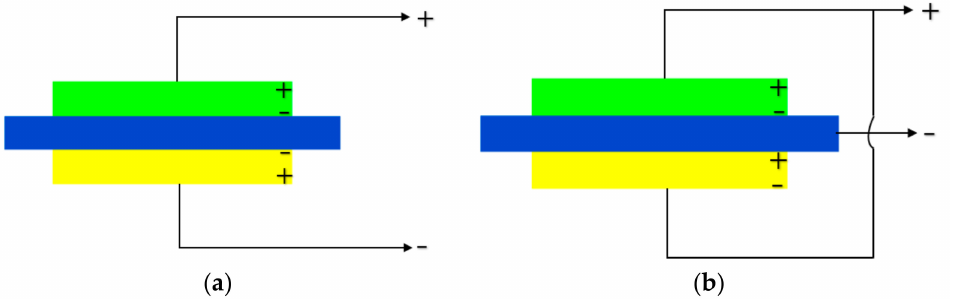
Figure 2. Two kinds of circuit connection modes: ( a ) series mode; ( b ) parallel